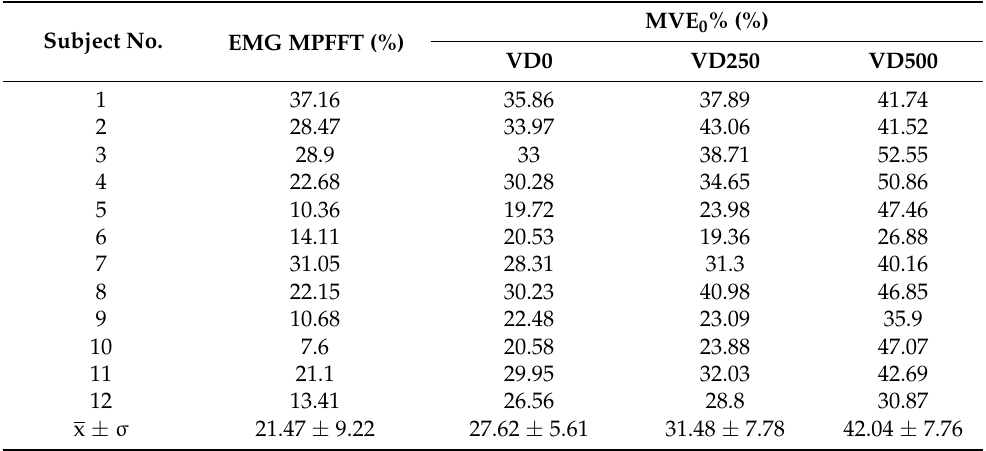
Table 1. The EMG MPFFT and the original muscle tension of the multifidus muscle of each subject in each tested